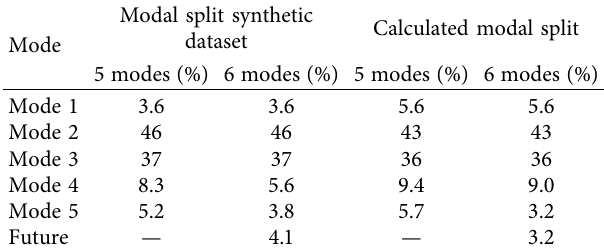
Table 5: Results synthetic